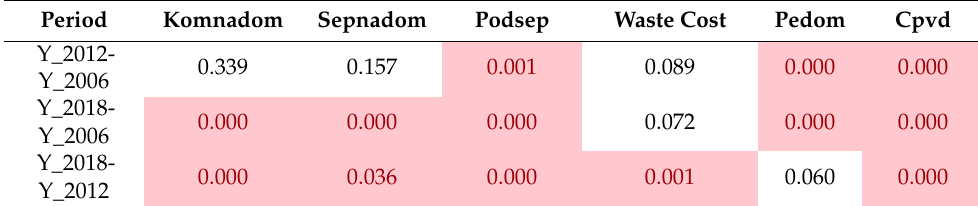
Table 5. Pair comparison of indexes and